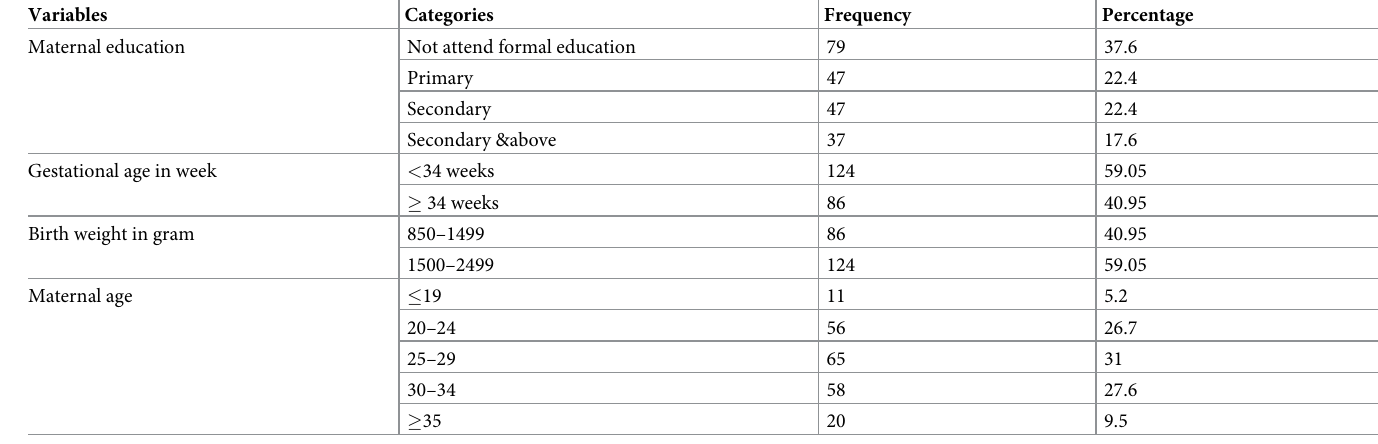
Table 1. Socio-demographic characteristics of the mothers and neonates admitted in NICU of DMCSH, FHCSH, and TGCSH comprehensive specialized hospitals, Amhara, Northwest Ethiopia, 2020 (N = 210).